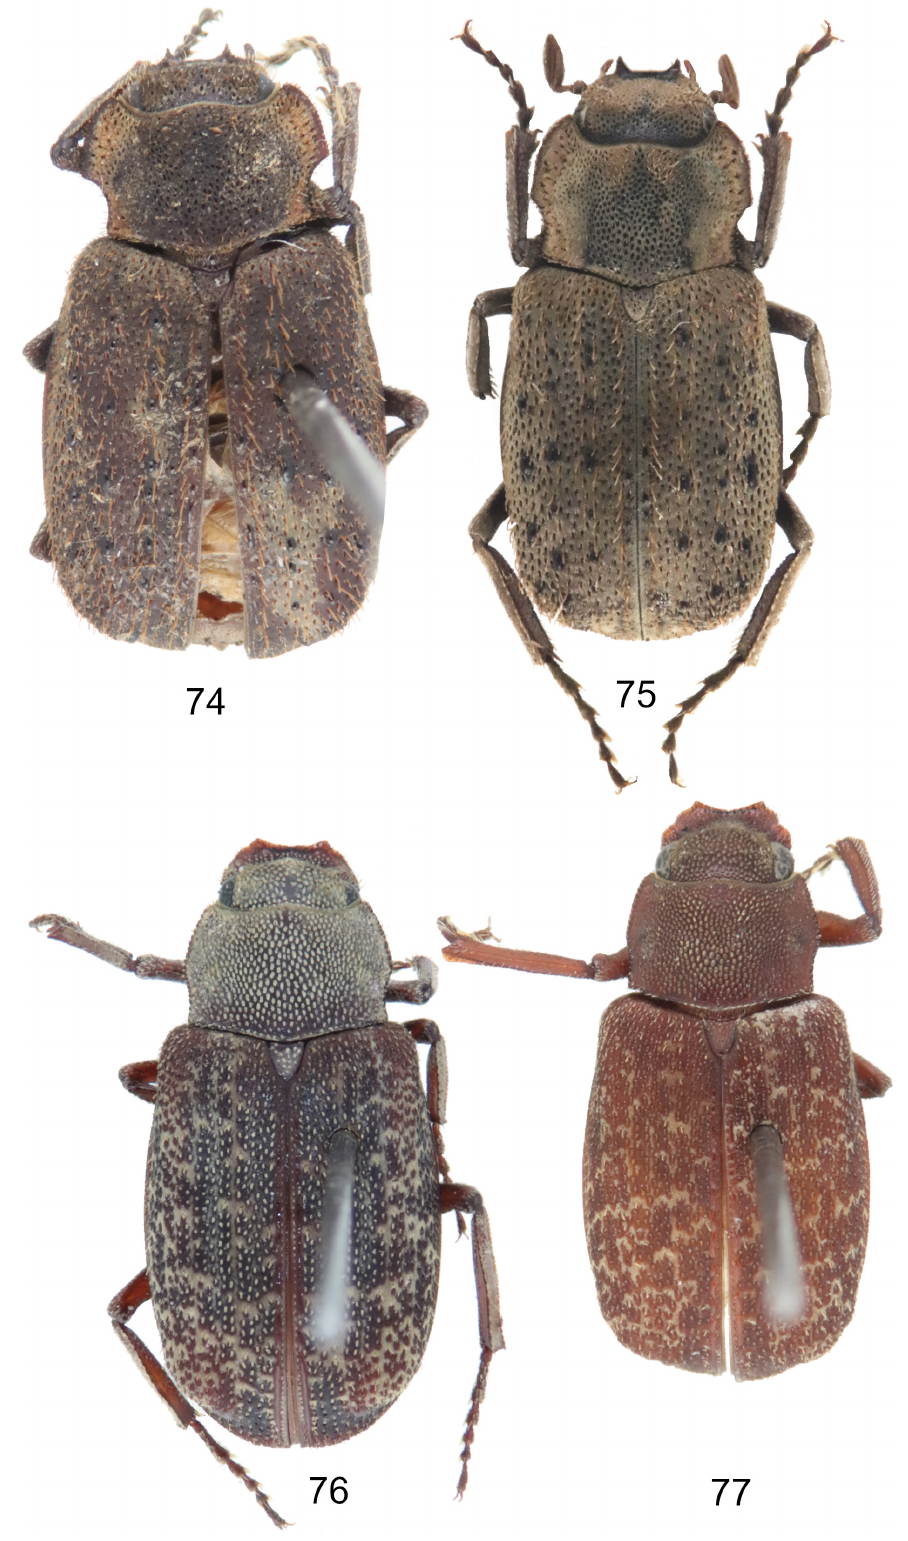
Figs 74–77. Papuan Maechidius Macleay, 1819, habitus, dorsal view. 74 . M. perlatus (Frey, 1969) comb. nov., holotype, ♂ (NHMB). 75 . Same, ♂ (SMNS). 76 . M. popei (Frey, 1969) comb. nov., holotype, ♀ (BMNH). 77 . Same, paratype, ♂ (BMNH). Not to